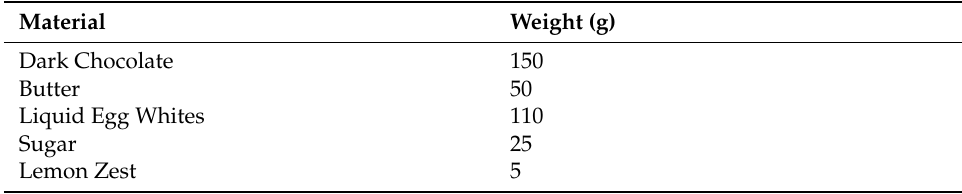
Table 4. Formulation of mousse